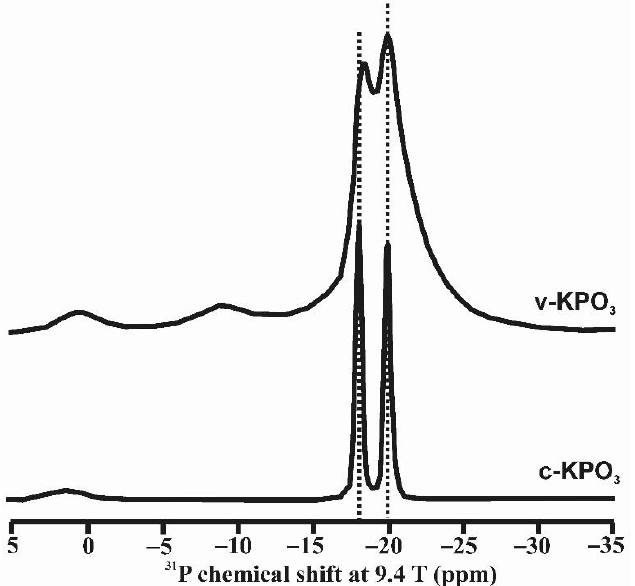
Figure 3. 31 P MAS NMR spectra of crystalline potassium metaphosphate, c-KPO 3 , and as quenched from the melt vitreous sample, v-KPO 3 . Two main resonances appear at ca. − 18 and − 20 ppm, attributed to the two crystallographic sites of phosphorus in c-KPO 3 , as well as in v-KPO 3 . Very small signals are also visible at lower fields, − 10 and 0 ppm; they are attributed to small amounts pyrophosphate and orthophosphate species, respectively. Reprinted with permission from Ref [36]. 2019, Elsevier. Experimental details for the acquisition of the 31 P MAS NMR spectra are given in [36]. An intermediate state of order of glasses exists in compounds in which NMR is able to resolve not only coordination polyhedra but also local chemical environments for the same coordination. Silicate and phosphate glasses consist of SiO 4 or PO 4 tetrahedra; borate glasses are considered anomalous because of their different electronic configuration.